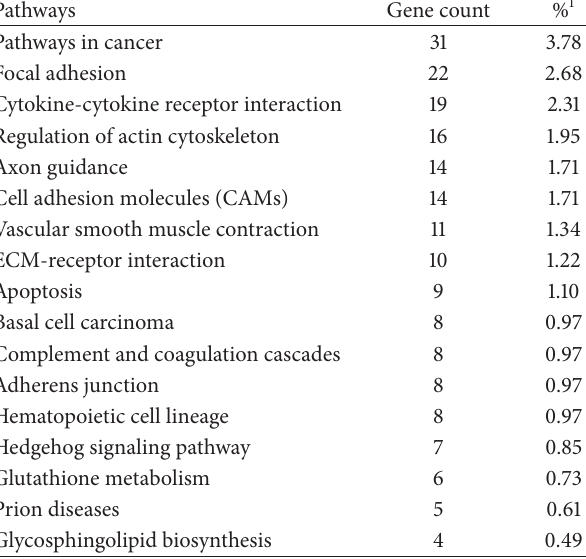
Table 1: Number of regulated ( > 2-fold; P < 0.05) Dunn/LM8 gene sets enriched in KEGG pathways